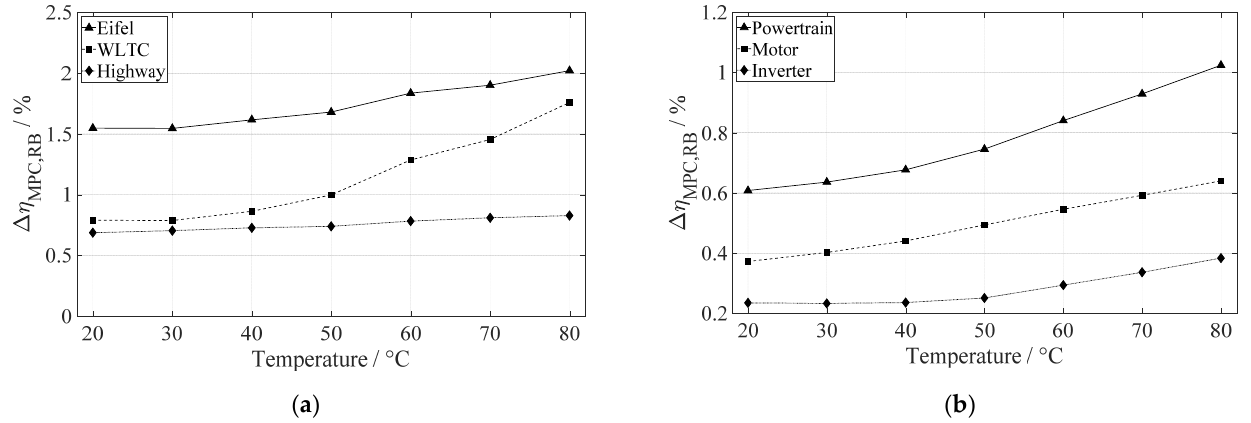
Figure 11. Efficiency increase using MPC in comparison to a rule-based strategy with shutter (RB) for component starting temperatures of 20–80 °C at 20 °C ambient temperature: ( a ) overall efficiency increase for all three driving cycles; ( b ) temperature-based efficiency increase for motor, inverter, and overall powertrain for the Eifel Cycle.